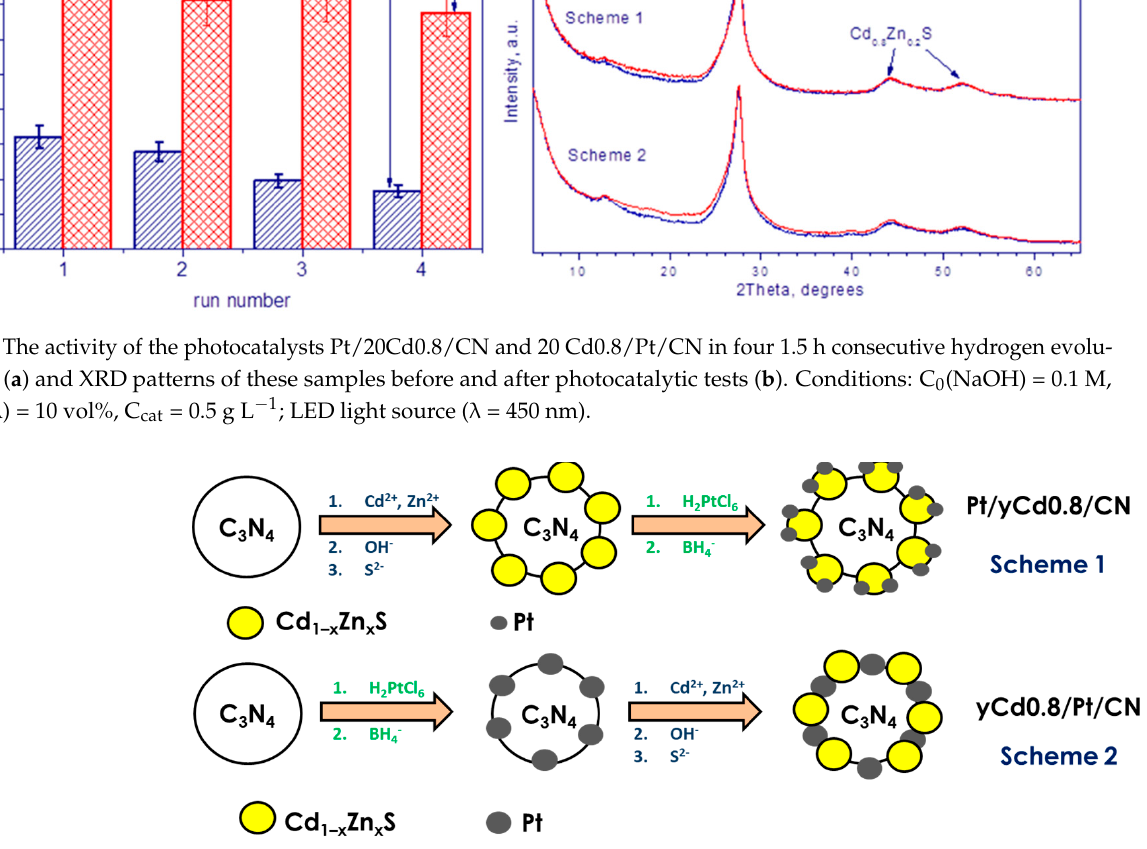
Figure 10. Scheme of the ternary photocatalyst synthesis.